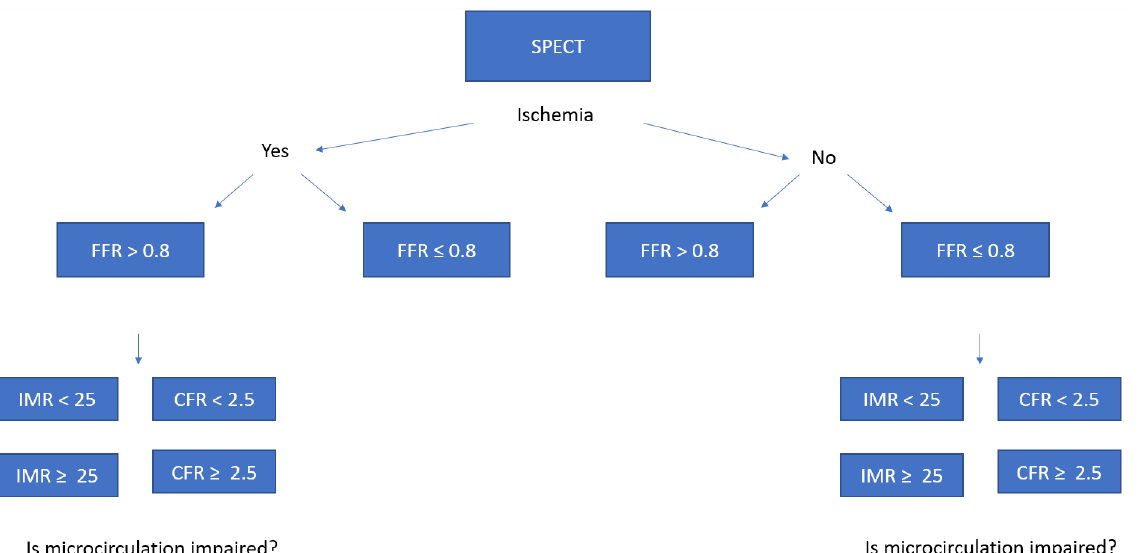
Figure 1. Study design and first endpoint.